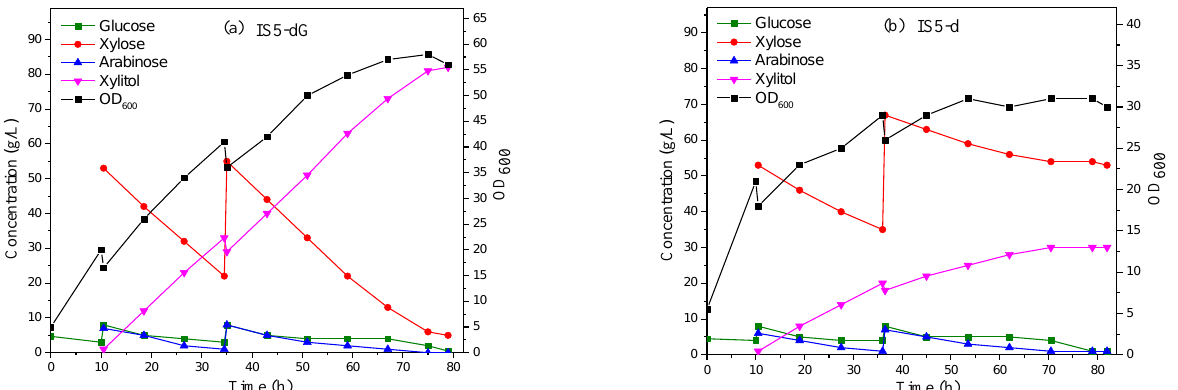
Figure 3. Bacterial growth and sugar concentrations of the fed-batch fermentation by IS5-dG ( a ) and IS5-d (( b ), as a control) to produce xylitol from corncob hydrolysate without lime treatment. The plots of the two sets of repeated experiments are presented in Figures S4 and S5 in the Supplementary Materials.